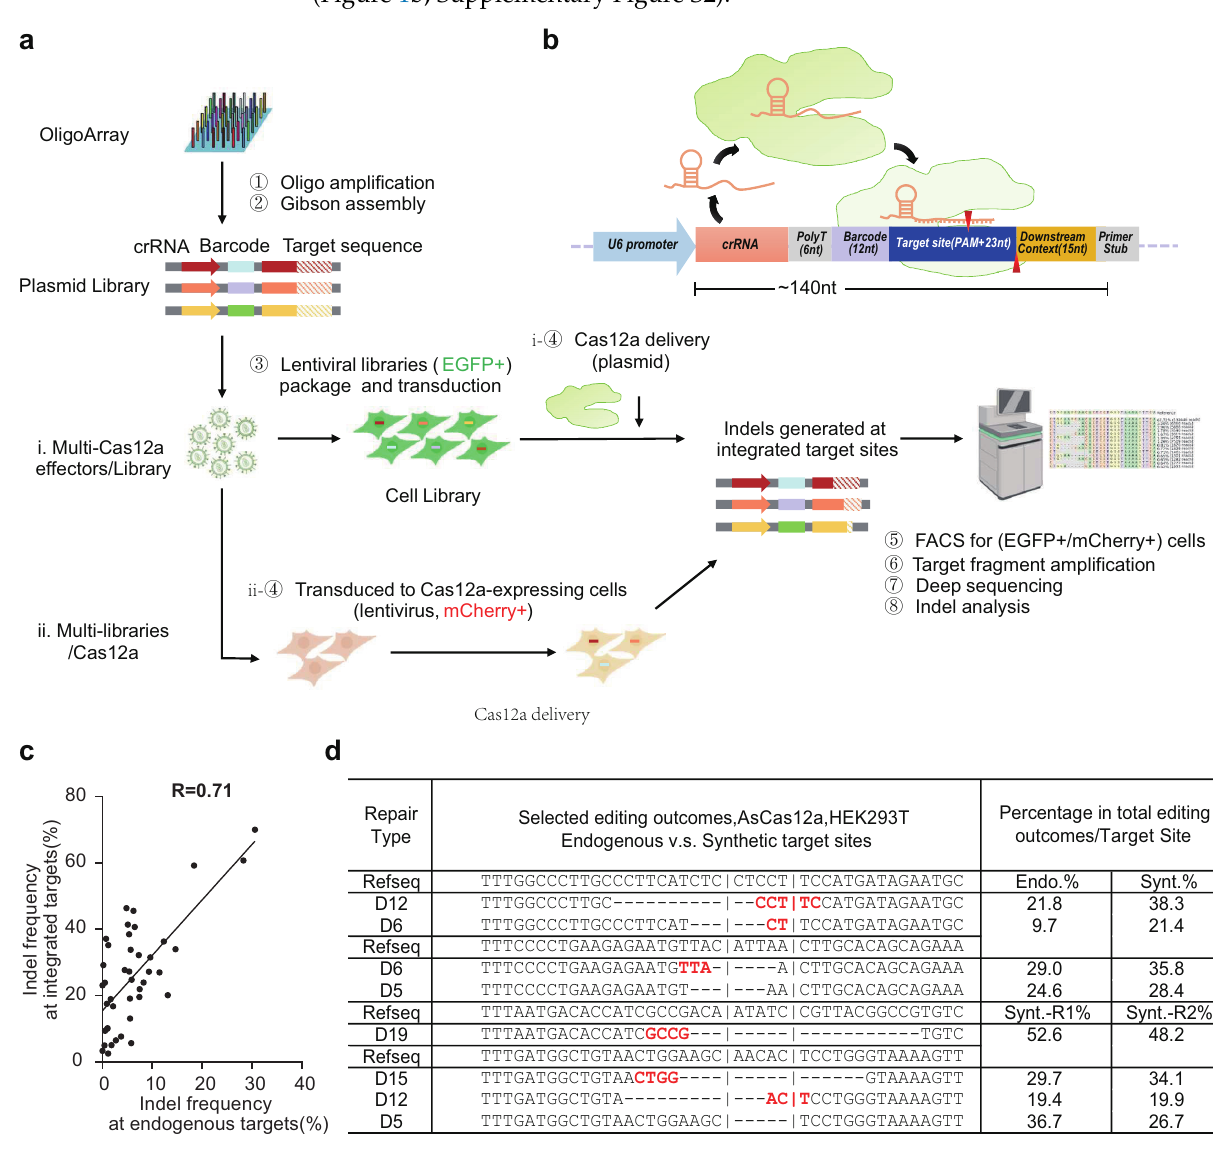
Figure 1. Paired guide-RNA–target library preparation and high-throughput profiling of editing activity mediated by diverse Cas12a effectors. The editing efficiency of Cas12a at synthetic target sites is reproducible and closely resembles endogenous editing profiles. ( a ) Schematic representation of a workflow for high-throughput assaying of Cas12a-mediated editing efficiency in human cells. ( b ) Design of oligonucleotides containing a self-cleavage crRNA–target paired library. ( c ) Correlation of indel frequencies measured at integrated target sites introduced via lentiviruses and corresponding endogenous sites edited by AsCas12a in HEK293T ( n = 42, Pearson (r)). ( d ) Sequence alignment examples showing the reproducibility of repair outcomes and the proportional editing efficiency generated by AsCas12a between synthetic (Synt.) and endogenous (Endo.) target sites. For details, see the Supplementary